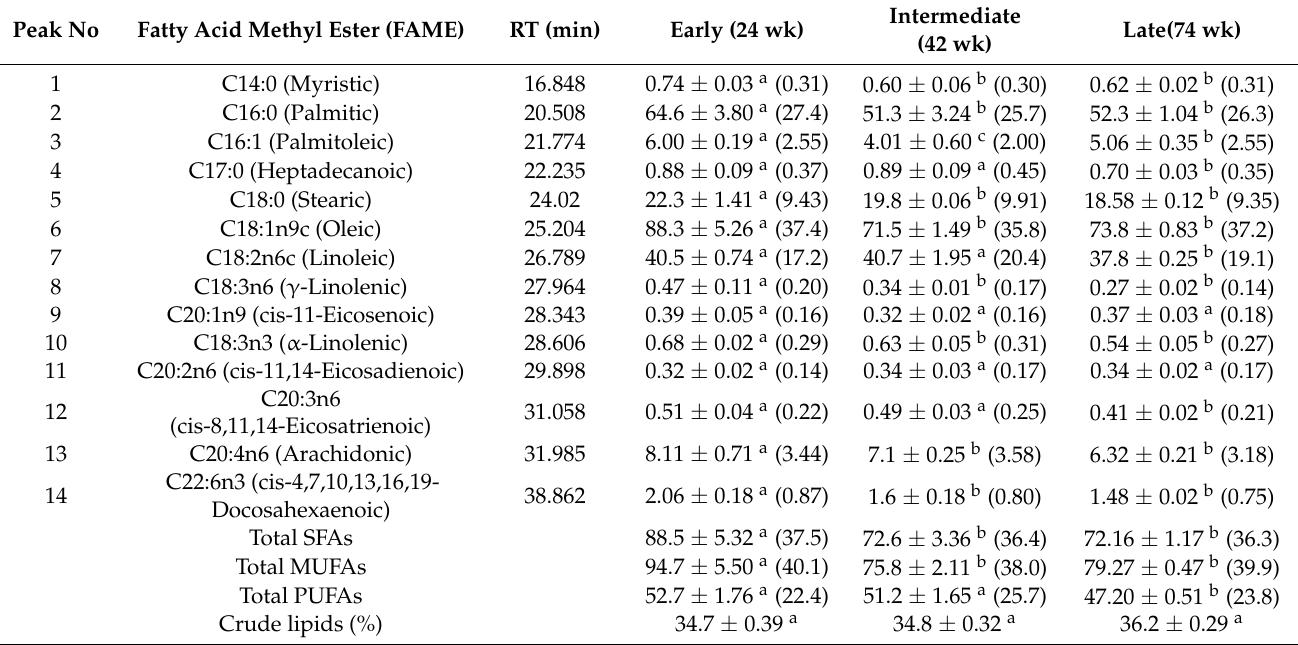
Table 2. Fatty acid composition of egg yolks obtained from early (24 wk), intermediate (42 wk), and late age laying (74 wk) hens. Peak